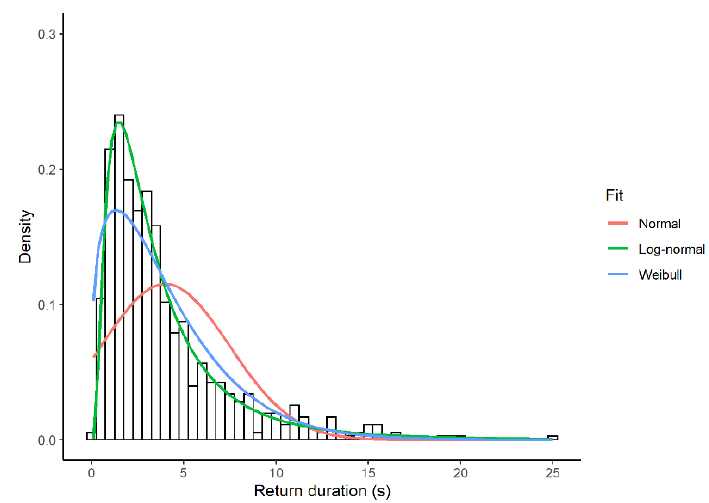
Figure 5. Relative fit of three theoretical distributions to the duration of return times (s) during sentinel bouts in Florida scrub-jay sentinels (n = 60). Fit to the negative exponential distribution is not shown for clarity. Return time represents how long it takes for the head to reorient in quadrant 1 after head movements from quadrant 1 to any of the other quadrants. One sentinel bout may contain several return times.